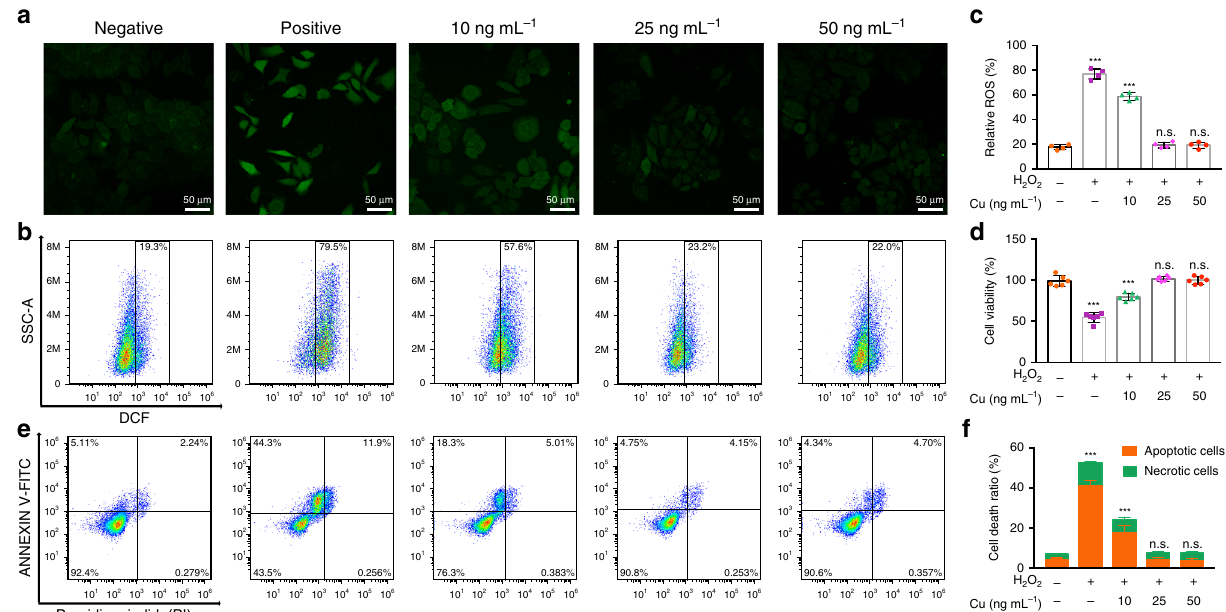
Fig. 4 Scavenging ROS with Cu 5.4 O USNPs in vitro. a Representative ROS staining (green fl uorescence) of HEK293 cells under different treatment conditions. b ROS levels in untreated and Cu 5.4 O USNPs-treated HEK293 cells incubated with 250 μ M H 2 O 2 . c Statistical analysis of ROS levels in HEK293 cells under different treatment conditions. d In vitro cell viabilities of HEK293 cells under different treatment conditions. e FACS results of cell apoptosis and necrosis distribution in untreated and Cu 5.4 O USNPs-treated HEK293 cells. f Statistical analysis of necrotic and apoptotic cell ratios in HEK293 cells under different treatment conditions. In c , d and f , data represent means ± s.d. from four ( c , f ) or six ( d ) independent replicates. *** P < 0.001; n.s., no signi fi cance, one-way ANOVA. Source data are provided as a Source Data fi